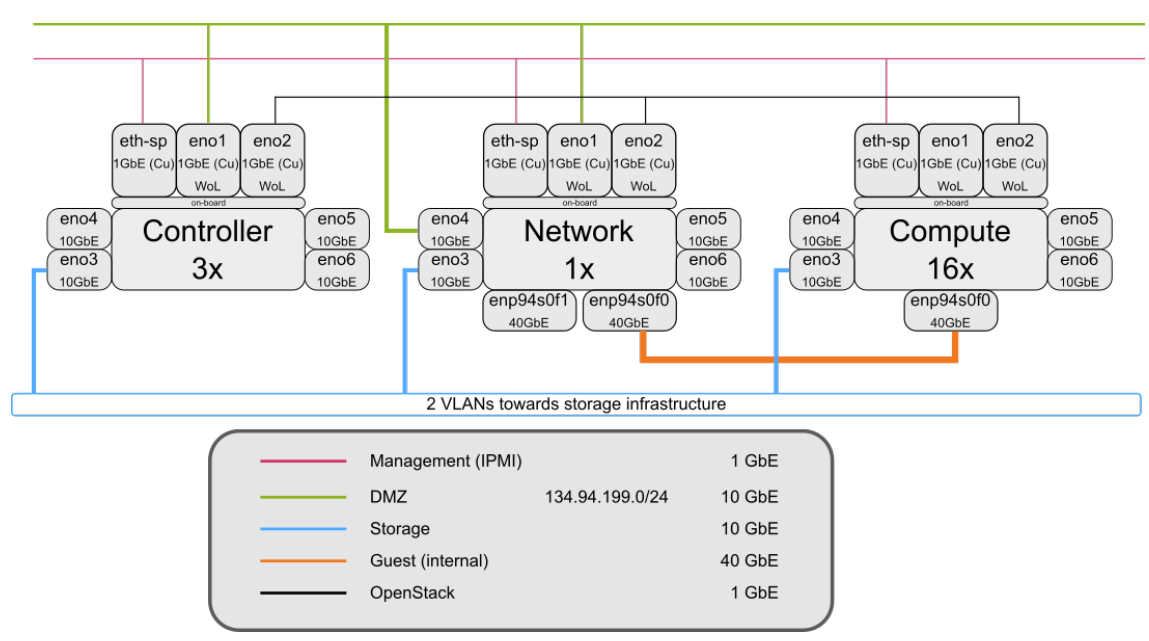
Figure 1: Network connections of the HDF Cloud system at